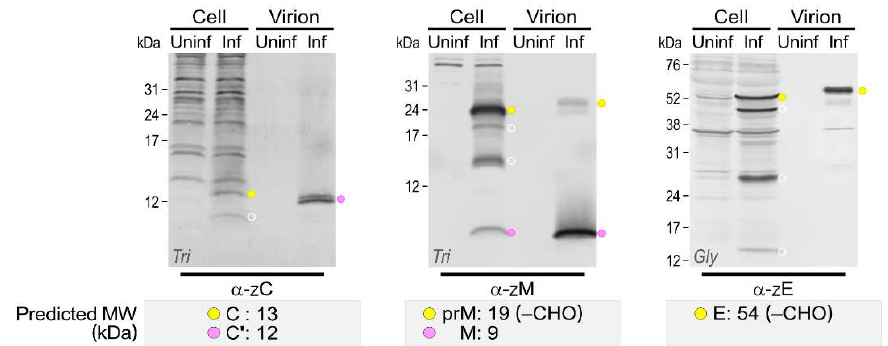
Figure 7. Profiling of virion-associated ZIKV proteins compared to their cell-associated counterparts. Vero cells were left uninfected (Uninf) or infected (Inf) with ZIKV rPRVABC-59 at an MOI of 1. For cell-associated viral proteins, total cell lysates were prepared by lysing the cell monolayers at 20 h post-infection. For virion-associated viral proteins, cell culture supernatants were collected at the same time point, and extracellular virions were pelleted by ultracentrifugation through a 20% sucrose cushion. Equivalent portions of total cell lysates and pelleted virions were resolved by SDS-PAGE on a glycine (Gly) or tricine (Tri) gel and analyzed by immunoblotting with α -ZC, α -ZM, or α -ZE. Molecular weight markers are shown on the left of each blot. The molecular weights of predicted C, C’, prM, M, and E proteins are indicated below each blot. Marked on each blot are the predicted proteins (yellow or pink dot) and presumed further cleavage/degradation products (white circle). CHO, N -glycosylation.